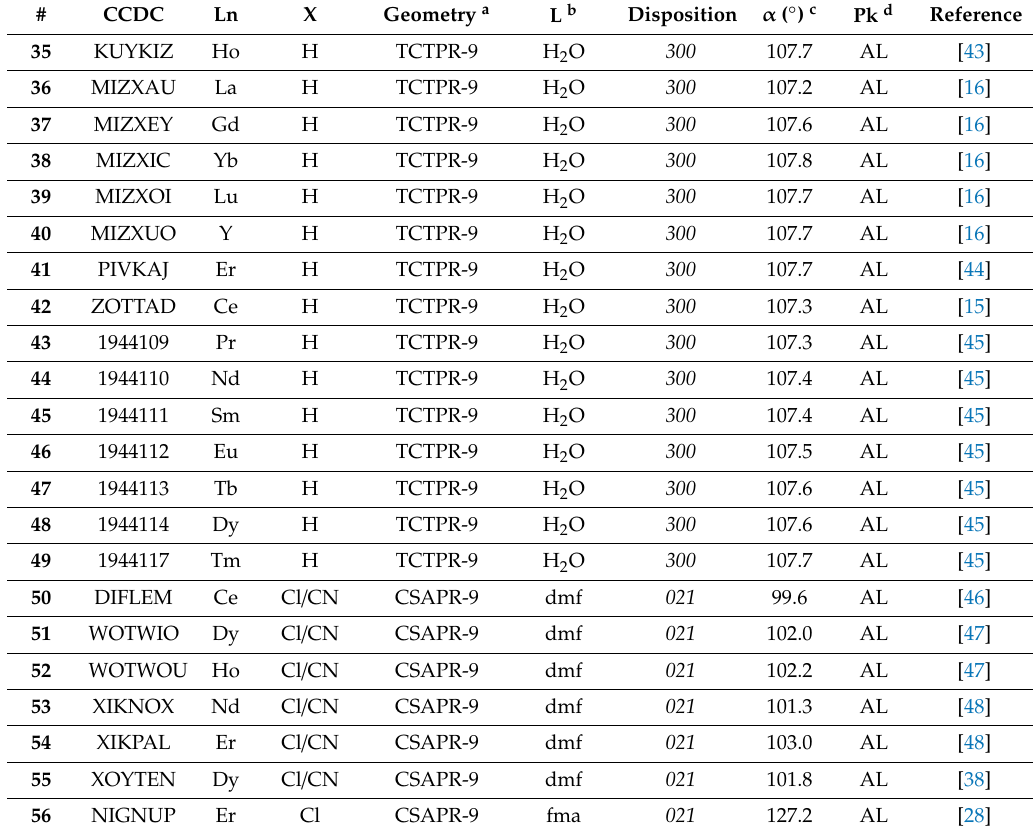
Table 2. Ln-anilato compounds with regular hexagonal 2D